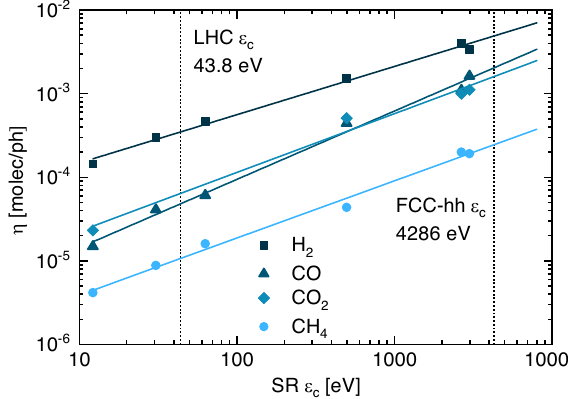
FIG. 3. η dependence on ε for RT baked Cu, read at a ph c common dose of 2 . 5 × 10 20 ph = m, using data from [6,31].